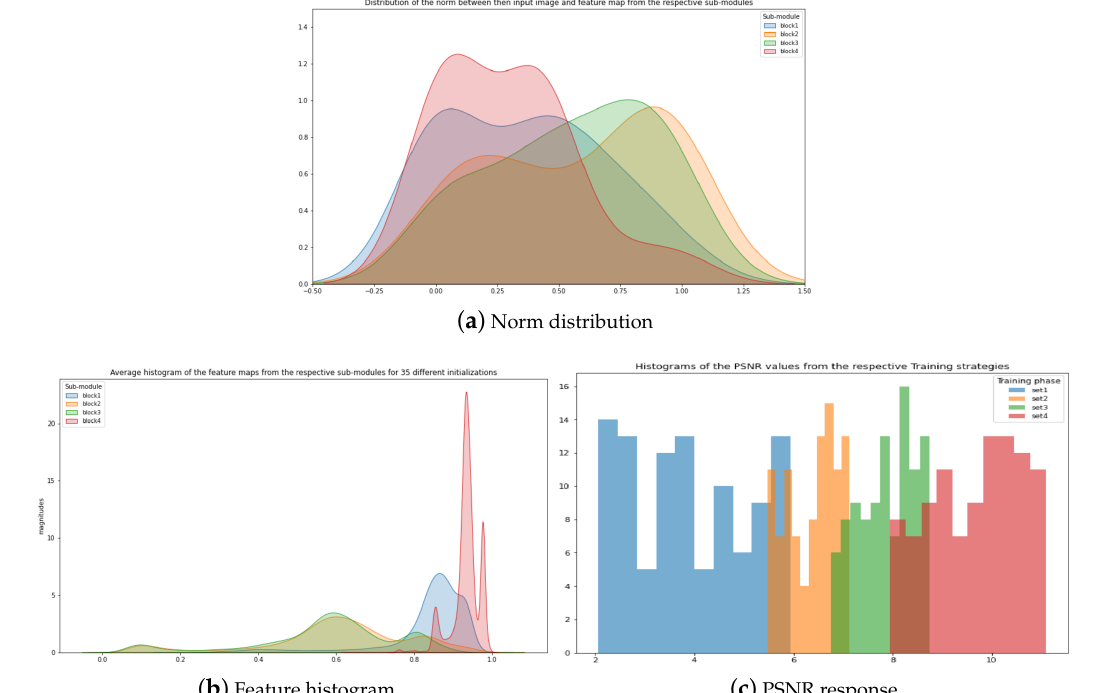
Figure 8. ( a ) Distribution of norm between the feature map response and the input image. ( b ) Average histogram of the feature maps from the sub-modules. ( c ) PSNR distribution for different training